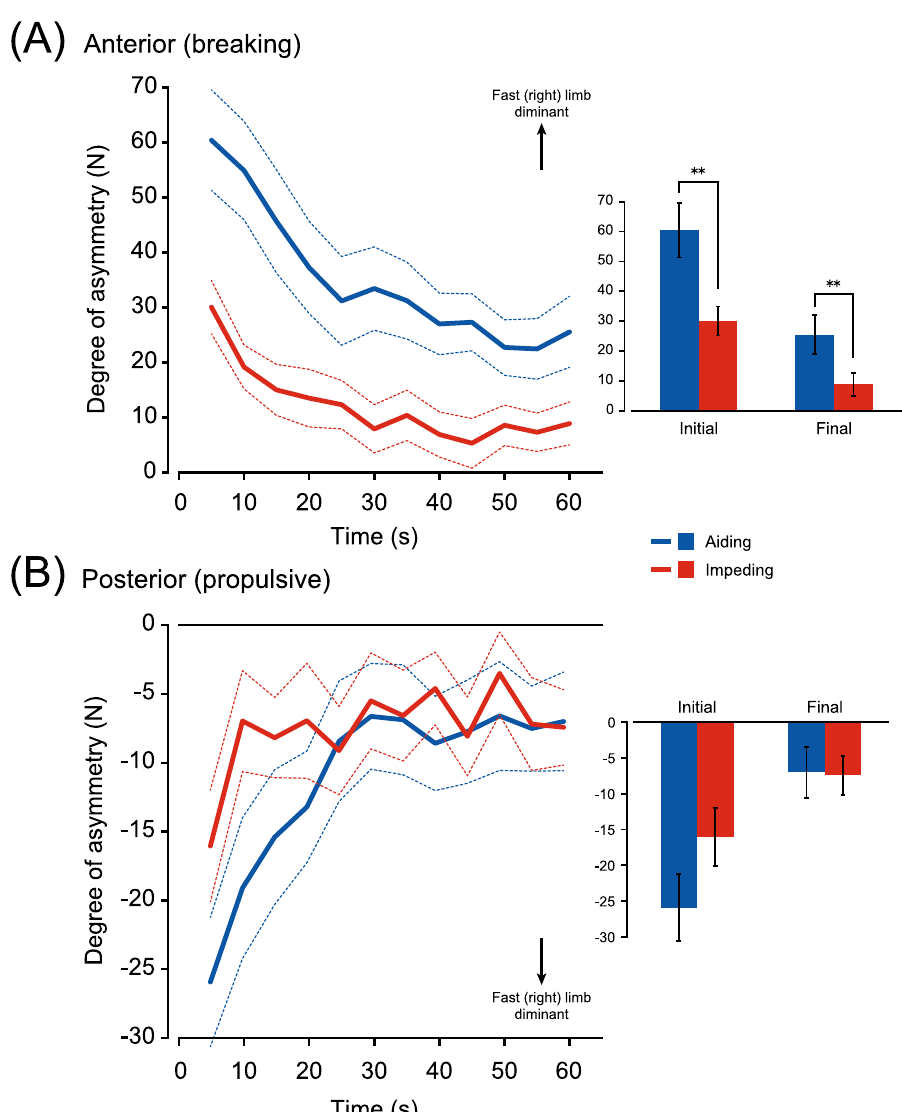
Figure 5. Comparison of the after effect sizes in the braking component ( A ) and the propulsive component ( B ) of the GRF between walking with aiding (blue lines) and impeding (red lines) force fields after adaptation with the aiding force field. Over the 1 min washout period, data were averaged for every 5-s bin. Data of eight subjects were obtained during washout 1 (corresponding to ➀ or ➃ in Fig. 1B), while those of the other eight subjects were from washout 2 ( ➁ or ➄ ) to overcome the ordering effects (n = 16). Lines show the mean (solid) and standard error of the mean (dotted), respectively. The bar graphs highlight the initial and final 5 s of the 1 min washout period. The error bars are the standard error of the mean. **P <